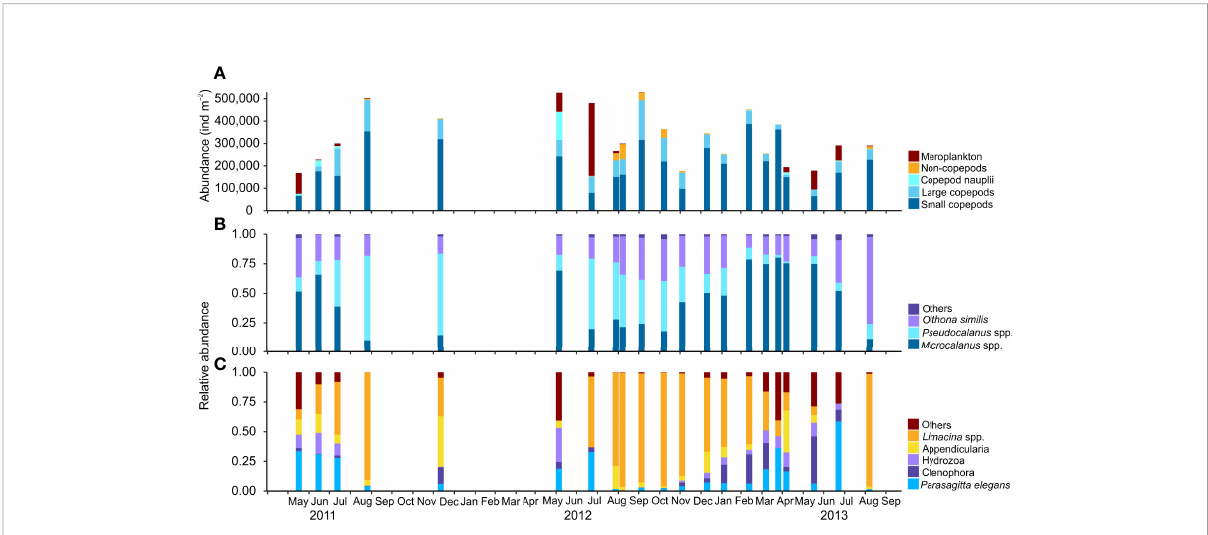
FIGURE 3 Monthly variability in zooplankton abundance (ind. m − 2 ) and species composition of dominant zooplankton groups during the study period May 2011 – September 2013 in Billefjorden, station BAB. (A) Total abundance of dominant zooplankton groups [large (total length > 2 mm) and small copepods (total length<2 mm)], copepod nauplii, non-copepod species, and meroplankton. (B) Relative composition of dominant small copepod taxa. (C) Relative composition of dominant non-copepod